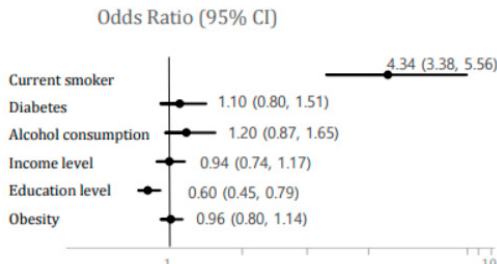
Figure 2. Odds ratios (ORs) (95% confidence intervals (CIs)) for high BCd. BCd levels were defined as follows: High BCd: >1.874 μ g/L (90th percentile of BCd levels). References for each predictor: smoking status = never ‐ smokers, diabetes mellitus = normal, alcohol consumption = none, income level = quartile 1, education level = less than high school diploma, obesity = normal.